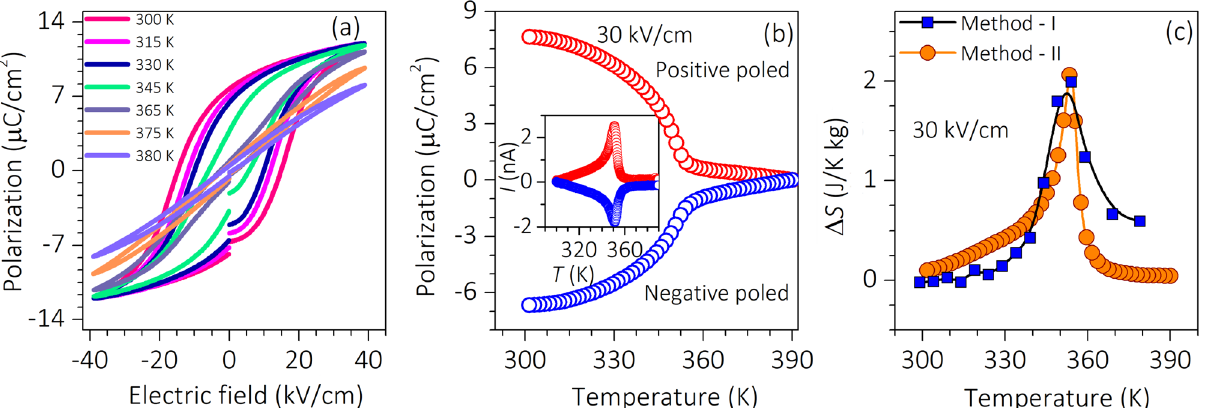
Figure 2. Temperature-dependent P and Δ S measurements of BBLT sample. ( a ) P–E hysteresis loop at different temperature. ( b ) Temperature-dependent P extracted from the pyroelectric measurements at positive and negative poled states. The inset shows the respective pyroelectric current response. ( c ) Δ S extracted from pyroelectric and polarization heated up to 390 K without any field and then cooled down to 300 K at 5 K/min under 30 kV/cm positive poling field. Then the pyroelectric current is measured during the heating cycle by maintaining the heating rate at 5 K/ min in the absence of poling field. The experiment is repeated but this time under the negative poling field of same idT , magnitude. The polarization values are extracted from the observed pyroelectric current using P = 1 A β (cid:31) where A , i , β , and dT are the surface area, pyroelectric current, heating rate, and change in temperature of the sample, respectively 28 . The temperature-dependent P values extracted under positive and negative poled states are plotted in Fig. 2b. The respective pyroelectric currents are shown in the inset of Fig. 2b. The symmetric nature of the P curves under positive and negative poled states indicates the ferroelectric characteristics of the sample. The P value of the samples extracted from the pyroelectric measurement is ~ 7.5 µC/cm 2 at 300 K, which is nearly matching with the value (8.3 µC/cm 2 ) obtained from the P-E hysteresis loop. The P shows a decreasing trend with temperature followed by a drop in value near the vicinity of T C . Also, the P response shows nearly saturating fea- tures over a narrow range of temperatures. These observed features could be attributed to the diffuse-phase tran- sition characteristics and structural inhomogeneity in the sample, reported in several ferroelectric systems 29–31 . To extract the EC characteristic parameter, the isothermal entropy change (Δ S ) and adiabatic tem- perature change (Δ T ), the respective thermodynamic Maxwell’s equations (∂ P /∂ T ) E = (∂ S /∂ E ) T , T P /∂ T ) and (∂ T /∂ E ) T = − E are used 4 . The EC characteristic parameters can be expressed as C P ρ (∂ ∂ T i ( T )� E , and � T = − T i ( T )� E 26,27 . Here, i ( T ) = A ∂ P = γ is a = A ∂ P = A γβ , where dP � S = − 1 dT A β C P ρ A βρ ∂ t ∂ T ∂ t pyroelectric coefficient, ρ and C P are mass density and heat capacity, respectively 26,27 . The (cid:31) E = E 1 − E 2 is the difference in initial ( E 1 ) and final ( E 2 ) poling fields. For comparison, the pyroelectric coefficient γ is calculated from both temperature-dependent P – E hysteresis (Method-I) and pyroelectric current (Method-II) measure- ments. The corresponding Δ S is extracted from the Maxwell’s equation by considering the poling fields lower limit E 1 = 0. The obtained Δ S from Method-I and Method-II as a function of temperature are plotted in Fig. 2c. The Δ S obtained from both the methods shows an increasing trend with temperature below T C , and displays maxima at T C . The calculated Δ S at T C (351 K) by the Method-I and Method-II are 1.99 and 2.05 J/K g at 30 kV/ cm, respectively. Looking at the perspective of the reported light-induced effect on ferroelectric characteristics of the non- centrosymmetric system, it would be interesting to study the EC phenomenon in the BBLT sample under the influence of light 21,22,32–36 . To investigate it, pyroelectric measurement is repeated under the illumination of 405 nm with 11.9 mW/mm 2 intensity of light at 30 kV/cm poling field. The corresponding temperature-depend- ent polarization graphs under dark and light illumination conditions are plotted in the inset of Fig. 3a. As the Δ S obtained from the two methods is comparable in value, Method-II is chosen owing to its ease in performing the experiment under light. The graphs exhibit enhanced polarization characteristics of the sample upon light illumination. This is in accordance with the variation shown by the P-E hysteresis loops measured under dark and light illumination conditions displayed in Fig. S1a (Supplementary information). The obtained P r value plotted as a function of light intensity in Fig. S1b (Supplementary information) depicts the linear variation of P r with light intensity. The unsaturated feature in polarization response derived from the pyroelectric current measurement below transition temperature could be due to the leakage current contribution upon light illumi- nation. However, the intrinsic origin of the phenomenon can be elucidated from the light-enhanced dielectric characteristics with negligible tanδ variations observed on BBLT sample 22 . In fact, a theoretical model is also proposed by V. M. Fridkin on the origin of photoferroelectrics, where the effect is correlated to the change in surface screening conditions associated to the trapped and surface charges 21 . Few mechanisms are also proposed to explain the photoferroelectric effect in the material. For instance, the increase in P r in (K 0.49 Na 0.49 Ba 0.02 ) (Nb 0.99 Ni 0.01 )O 2.995 sample is observed by Bai et al. which is claimed to be originated from the ferroelectric domains contribution 34 . Importantly, the contributions of ferroelectric domain and lattice deformation on the